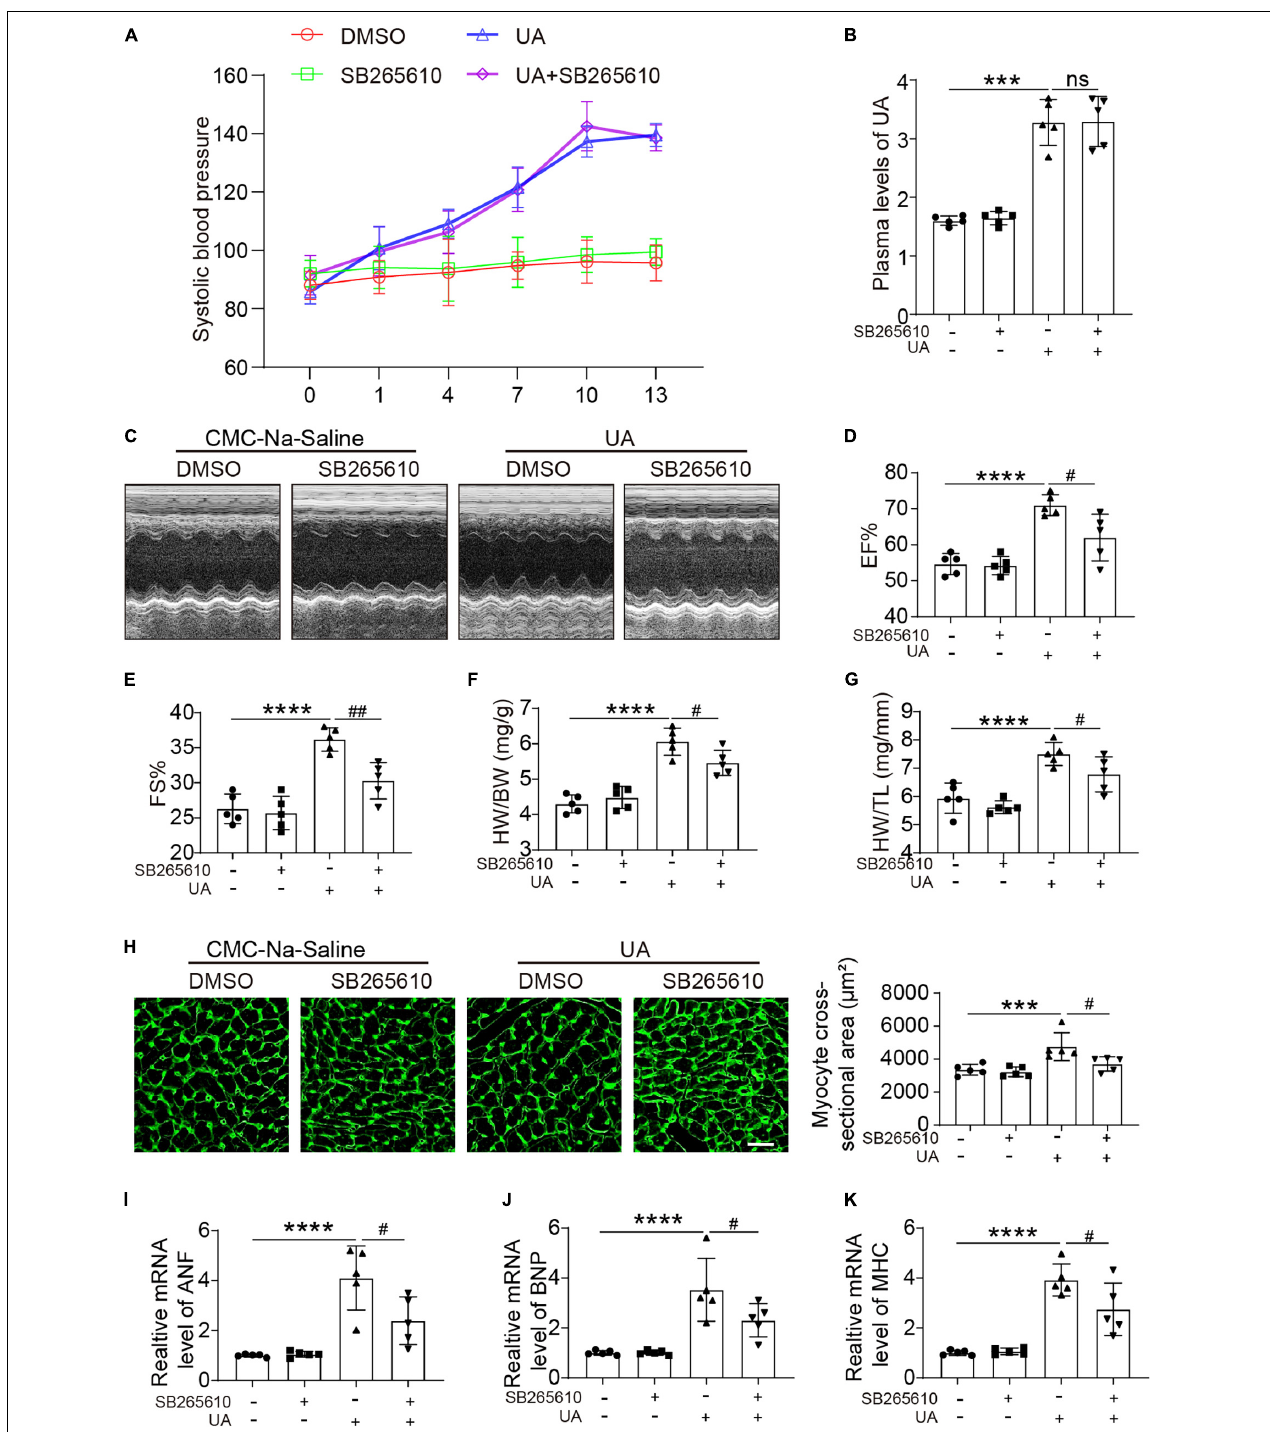
FIGURE 2 | CXCR2 antagonist preserved cardiac dysfunction in response to UA. Systolic blood pressure of mice subjected to CMC-Na-saline or UA, with or without CXCR2 antagonist treatment at day 14 (A) . Plasma levels of UA in mice subjected to CMC-Na-saline or UA, with or without CXCR2 antagonist treatment at day 14, were measured by ELISA (B) . Representative M-mode echocardiography of left ventricular (LV) chamber (C) and echocardiographic assessment of EF% (D) and FS% (E) from CMC-Na-saline or UA-treated mice, with or without CXCR2 antagonist treatment at day 14. Heart weight/body weight (HW/BW) (F) and heart weight/tibia length (HW/TL) ratios (G) were analyzed. Heart cross-sectional areas were stained with wheat germ agglutinin (WGA) (H) . Real-time PCR analysis of the mRNA expression of hypertrophic markers at day 14 (I–K) . Statistical analysis was performed by two-way ANOVA. *** P < 0.001, **** P < 0.0001 vs. CMC-Na-saline + dimethyl sulfoxide (DMSO); # P < 0.05, ## P < 0.01 vs. UA + DMSO; n = 5/group; ns: non significance.